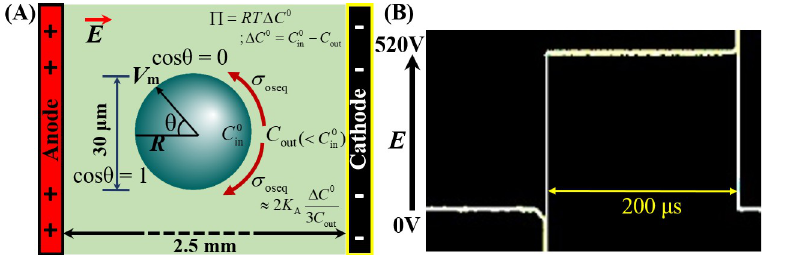
Fig 1. Illustration for applying the electric field in GUVs. (A) Schematic diagram of experimental set-up for the constant electric tension-induced rupture of GUVs under osmotic pressure. (B) An IRE signal of pulse width 200 μ s.